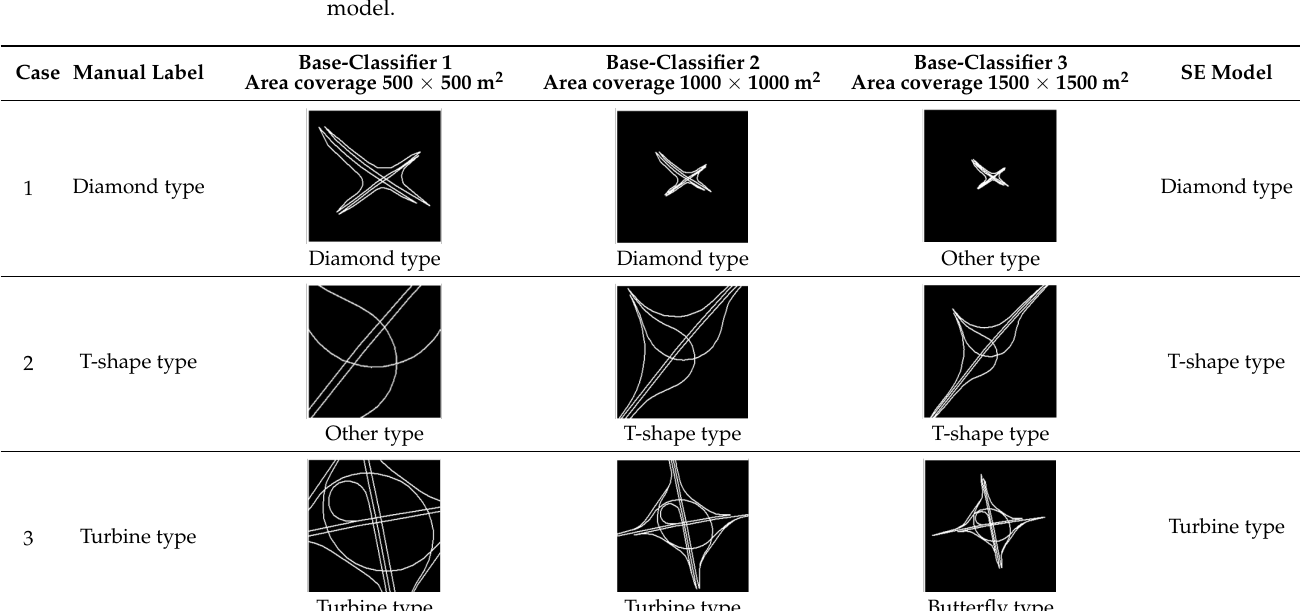
Table 3. Comparison of classification results using the base-classifiers and stacking ensemble (SE)